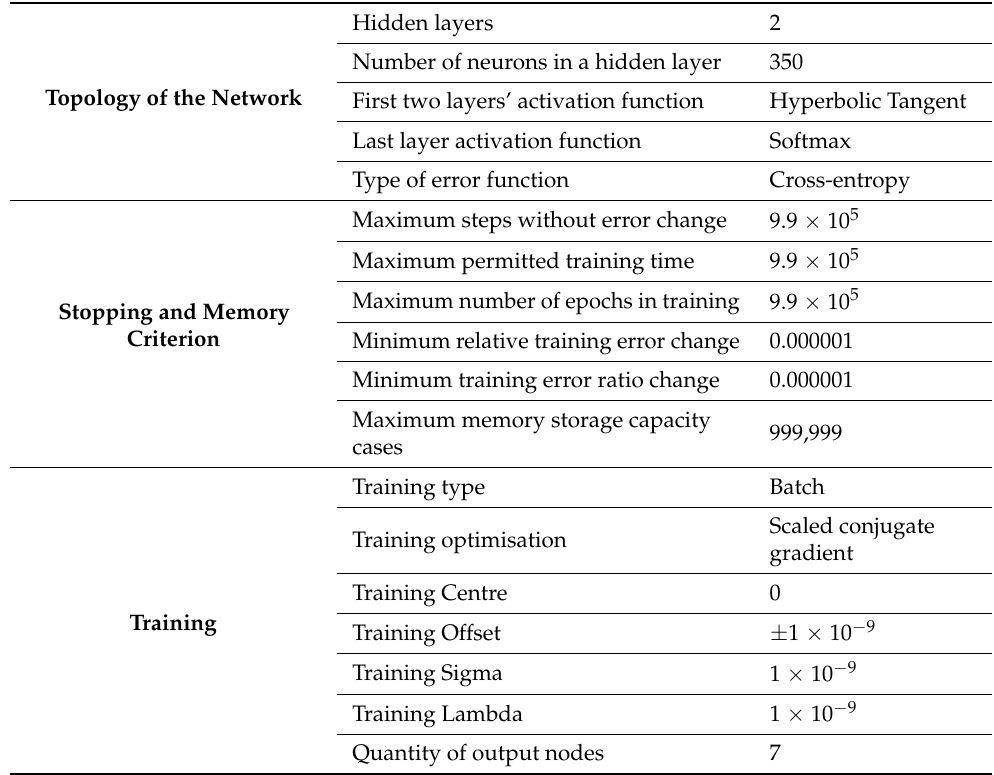
Table 2. Deep learning network